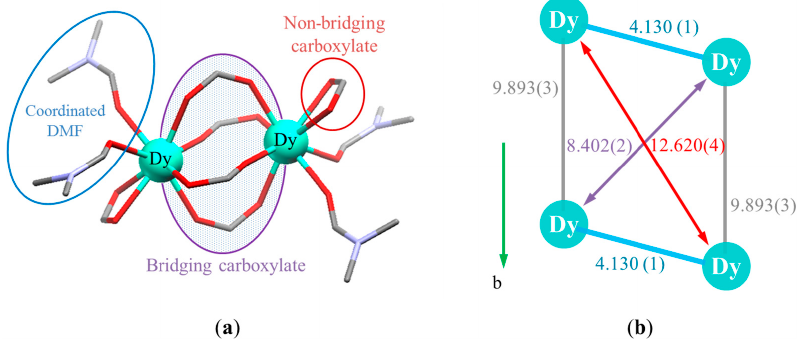
Figure 2. Drawings of ( a ) the Dy(III) dinuclear clusters in 1 ; and ( b ) the Dy-Dy distances in Å.